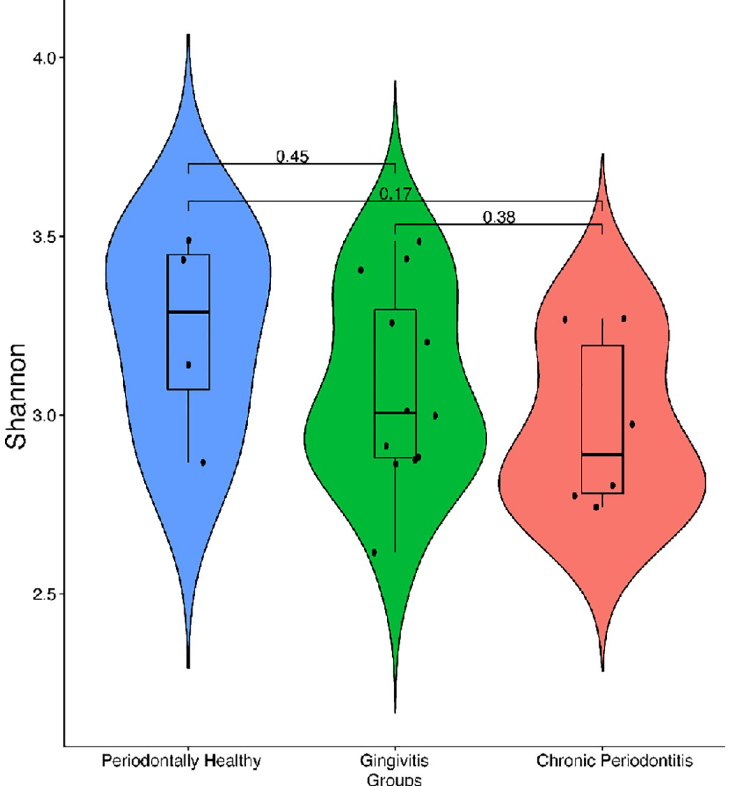
Fig 3. Taxonomic diversity of bacterial communities in healthy and diseased samples. Violin plots show the distribution and density of oral bacteria across three groups of patients. Overall, 22 samples were analyzed being 4 (18.2%) retrieved from healthy patients, 12 (54.5%) from those with gingivitis, and 6 (27.3%) from those with chronic periodontitis. Alpha diversity was measured using the Shannon index (Y-axis). The boxes represent the interquartile range (IQR) between the first and third quartiles (25th and 75th percentiles, respectively). The vertical line inside the box defines the median. Whiskers represent the upper and lower adjacent values. P -values of comparisons are displayed above each block